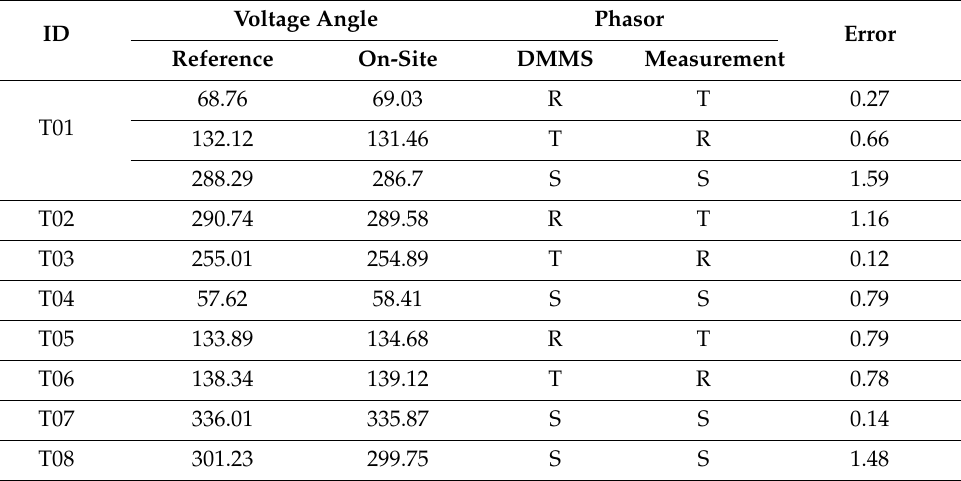
Table 1. Identification results of distribution room